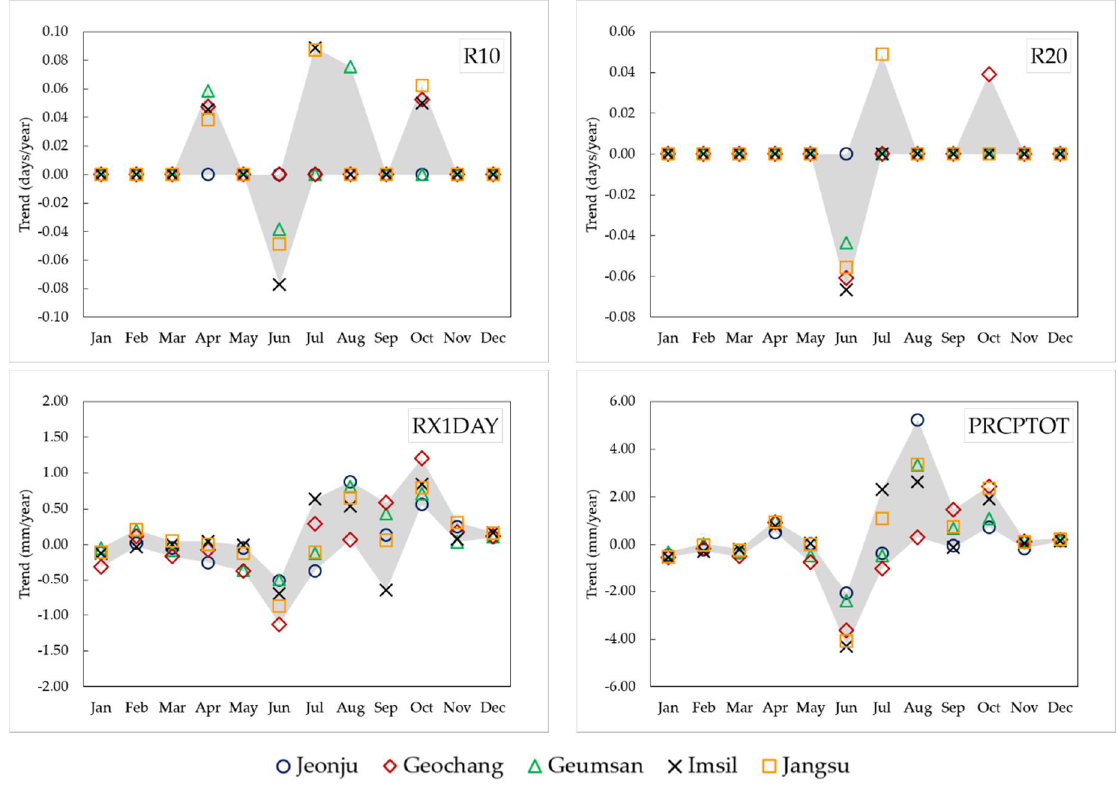
Figure 6. The monthly trend magnitudes of all precipitation indices at the